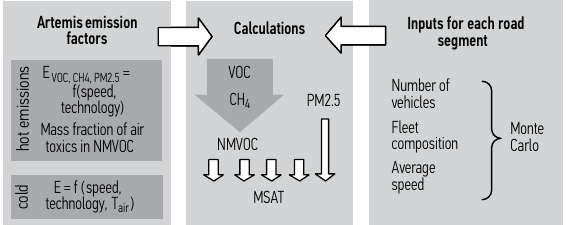
Fig. 1. Calculation algorithm for hazardous air pollutants implemented in TREM–HAP